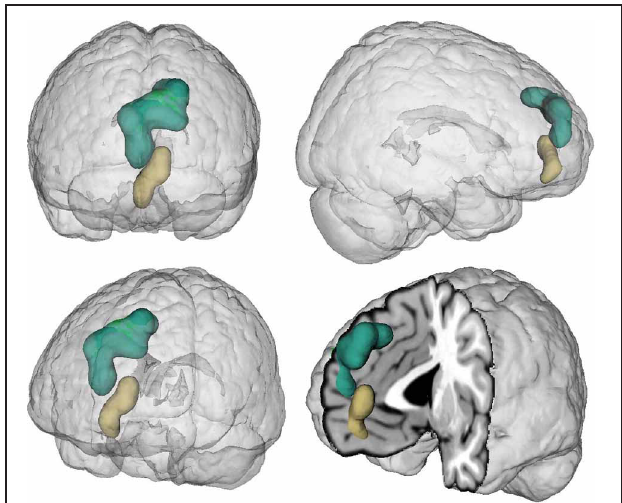
FIGURE 1 | Location of the seed regions. Seeds were drawn from an earlier coordinate-based neuroimaging meta-analysis on perspective-taking, which yielded two clusters of convergent brain activity in the ventral (beige) and dorsal (green) medial prefrontal cortex (Bzdok et al., 2012c). The centers of mass of the vmPFC and dmPFC seed are − 4/52/ − 2 and − 6/56/30, respectively. These two seeds represent a functional-structural segregation in the medial prefrontal cortex related to higher social-cognitive processing and provided the basis for the present quantitative analyses. The seeds were rendered into a T1-weighted MNI single subject template using mango (multi-image analysis GUI;